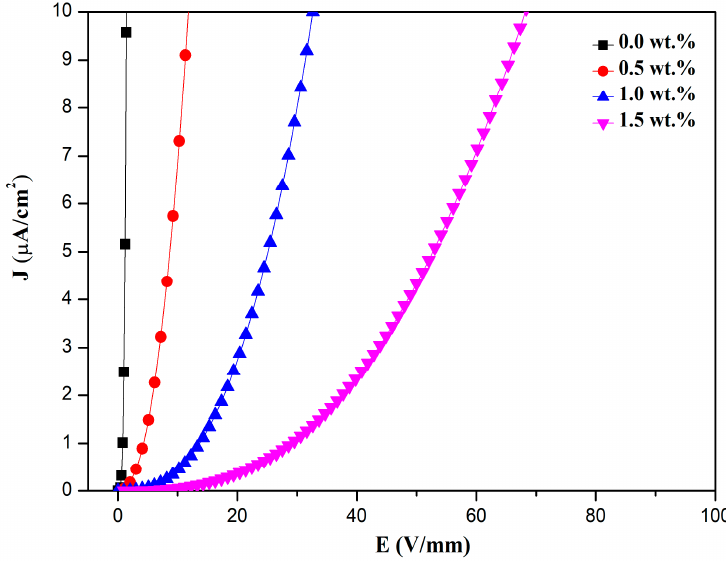
Figure 4. J-E characteristics of the varistor ceramics doping with various Pr 6 O 11 . In the pre-breakdown region, the linear curves of J-E response for all samples indicate that the resistivity of the varistor ceramic samples before breakdown voltage is slightly higher than the nonlinear curves of J-E response. The J-E curves at different concentrations of Pr 6 O 11 resemble a nonlinear response with a high resistivity region at the left of the breakdown voltage and a low resistivity region at the right of the breakdown voltage. The values of the nonlinear coefficient are decreased for Pr-doped samples, whereas the J-E curves are shifted to the right of breakdown voltage by Pr. However, the most important parameter here is the breakdown voltage. By increasing the Pr-doping amounts to 1.5, the varistor breakdown field of the ceramic evidently increased. The breakdown field of the varistor ceramics is related to the ZnO grain size and the applied electric field at each grain boundary [35,36]. The decrease in the average grain size with further increase in the Pr- doping amount can be clarified by the increase in the numbers of grain boundaries between the electrodes, thereby increasing the breakdown voltage and enhanced the nonlinearity of the varistor ceramics. A high nonlinear coefficient leads to the increased breakdown field of the ceramic samples [37]. The increase in the breakdown voltage with further increase in the Pr-doping content also reduced the leakage current, indicating that it occurs at lower current density due to the increase in barrier height at the grain boundaries. The nonlinear electrical properties of the Pr-added samples is lower than that of the BaTiO 3 - doped ceramic for electric fields with strengths lower than 10 V/mm. It has been reported that most of the Pr 6 O 11 -doped ZnO varistor system exhibited low nonlinear coefficient value at a low-voltage range